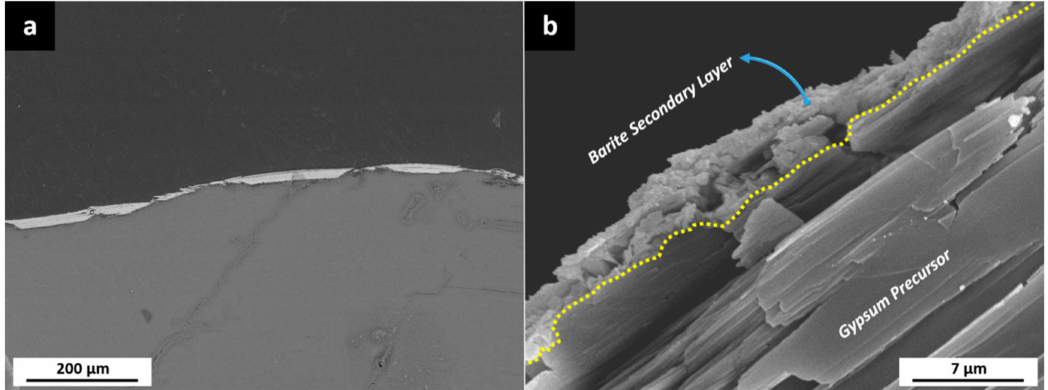
Figure 8. ( a ) BSE image of a cross section cut perpendicular to the gypsum (010) surface after 3 h interaction showing the transformed layer. ( b ) After seven days of interaction the width of the replaced layer does not